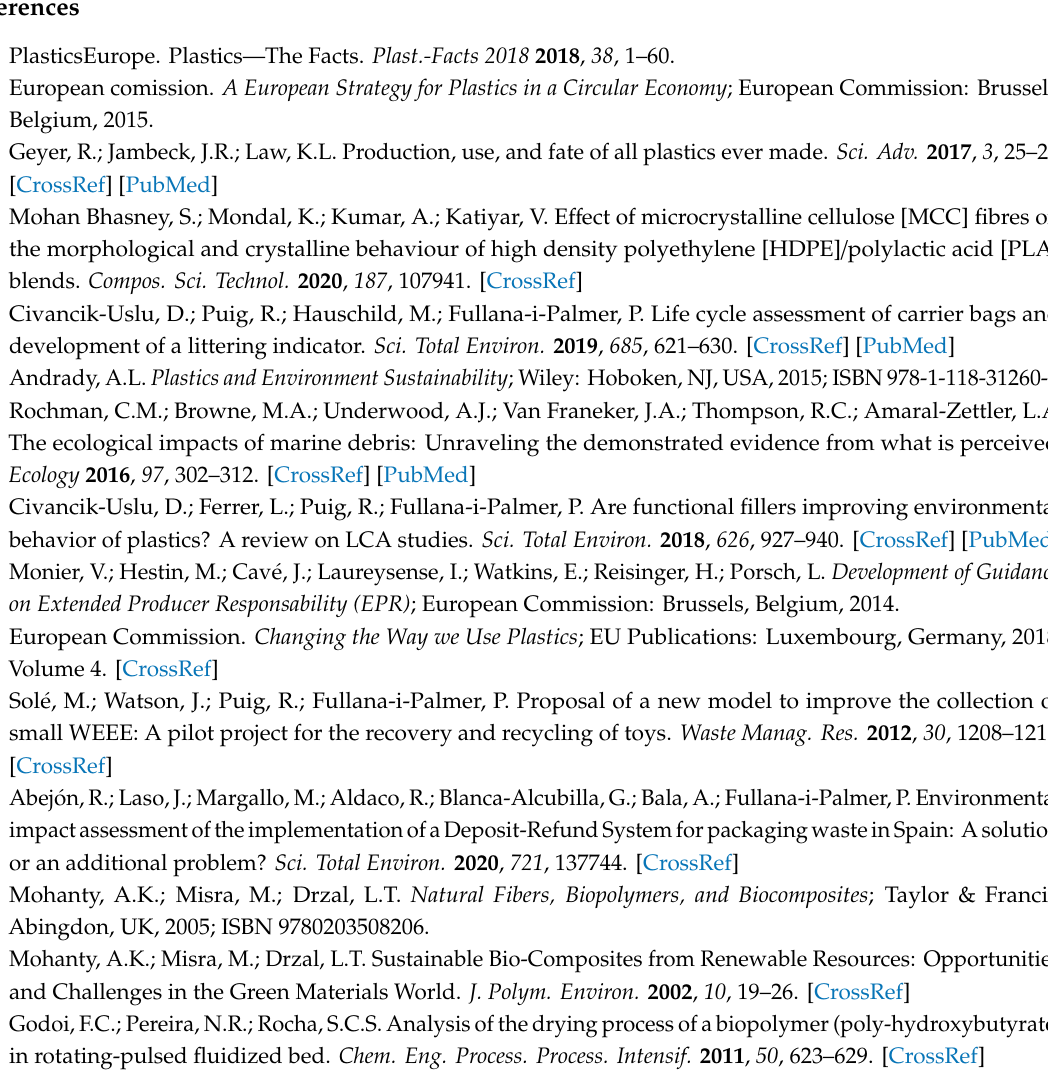
Table S1: List of polypropylene homopolymer, Table S2: List of polypropylene copolymer, Table S3: List of high density polyethylene, Table S4: List of acrylonitrile butadiene styrene, Table S5: List of polystyrene, Table S6: List of polyamide 12, Table S7: List of polyamide